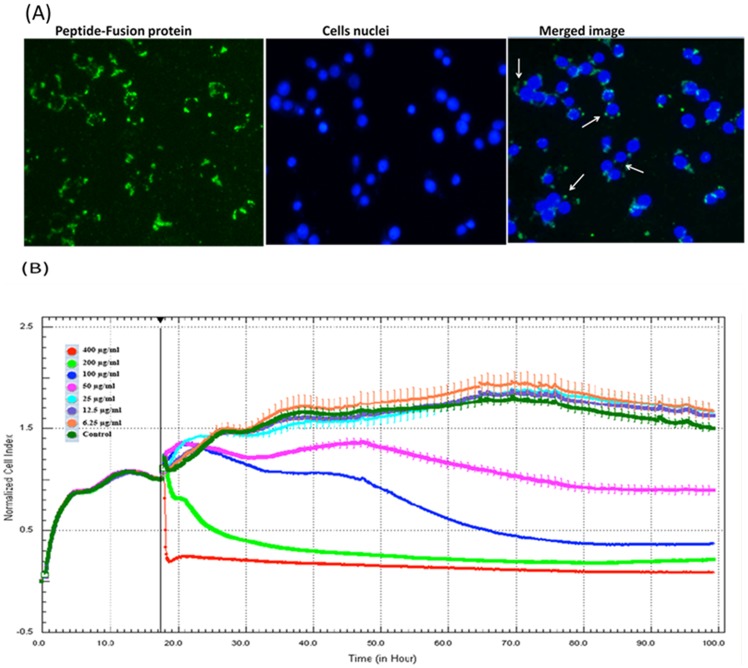
Peptide-fusion protein uptake and real time cell proliferation assay.(A) Cellular uptake of the peptide-fusion protein was analyzed by immunostaining images that show localization of peptide-fusion protein around cells nuclei. (B) Cell proliferation was measured using xCELLigence Real-Time Cellular Analysis (RTCA) system. Cell viability and growth was monitored continuously after incubating the cells for 18 h at standard condition and applying increased concentrations of the PG1-MAP30-PLSN protein (6.25, 12.5, 25, 50, 100, 200 and 400 μg/ml or 0.17, 0.34, 0.67, 1.35, 2.70, 5.40 and 10.81 μM).The effects of the peptide-fusion protein on cell proliferation were insignificant at the doses less than 25 μg/ml (0.67 μM) for 82 h as the cell index was similar with untreated control cells. Cell proliferation was considerably decreased at the dose more than 50 μg/ml (1.35 μM).